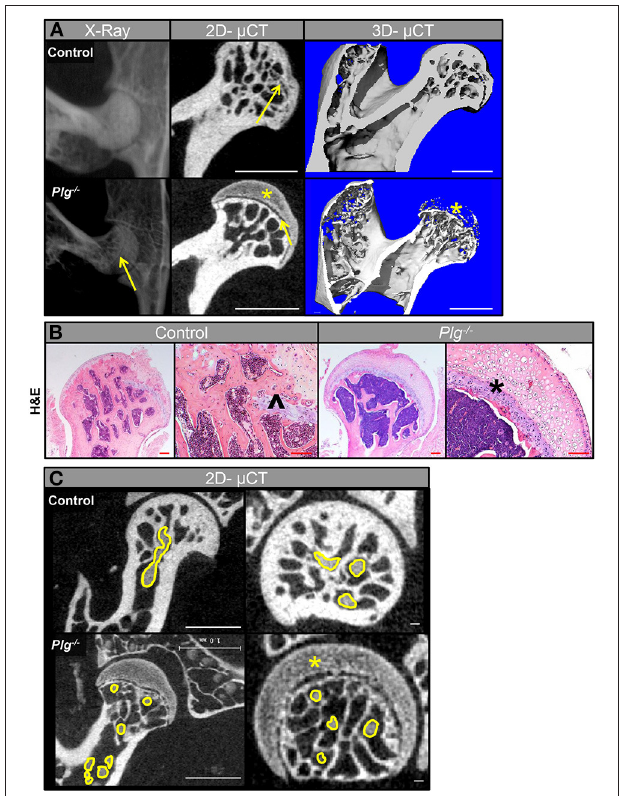
FIGURE 4 | Vascularization and subsequent ossification of the proximal femoral epiphysis in mice with impaired fibrinolysis. (A) Radiographs ( in vivo ) and µ CT images showed that the proximal epiphysis is ossified with partial physeal closure (yellow arrow) in WT control mice at 13 weeks of age, but that the proximal epiphysis remains unossified (yellow asterisk) and the physis remains open (yellow arrow) in Plg − / − littermates (scale bars, 1mm). (B) Histological analysis of femoral heads at 13 weeks of age confirmed ossification of the epiphysis and vascular penetration beyond the physeal remnant (black caret) in the control mice, whereas the epiphysis in Plg − / − mice is composed of disorganized hypertrophic cartilage (black asterisk) and an inactive physis [H&E, magnification 2.5 × and 10 × (scale bars, 100 µ m)]. (C) 2D- µ CT images from mice injected with angiogram contrast material at 20 weeks of age delineated the epiphyseal vascular supply of the proximal femur in WT control and Plg − / − mice (vasculature outlined in yellow). 2D- µ CT images also show that control mice have an ossified epiphysis and a fully resorbed physis by 15 weeks of age, whereas Plg − / − mice have not ossified